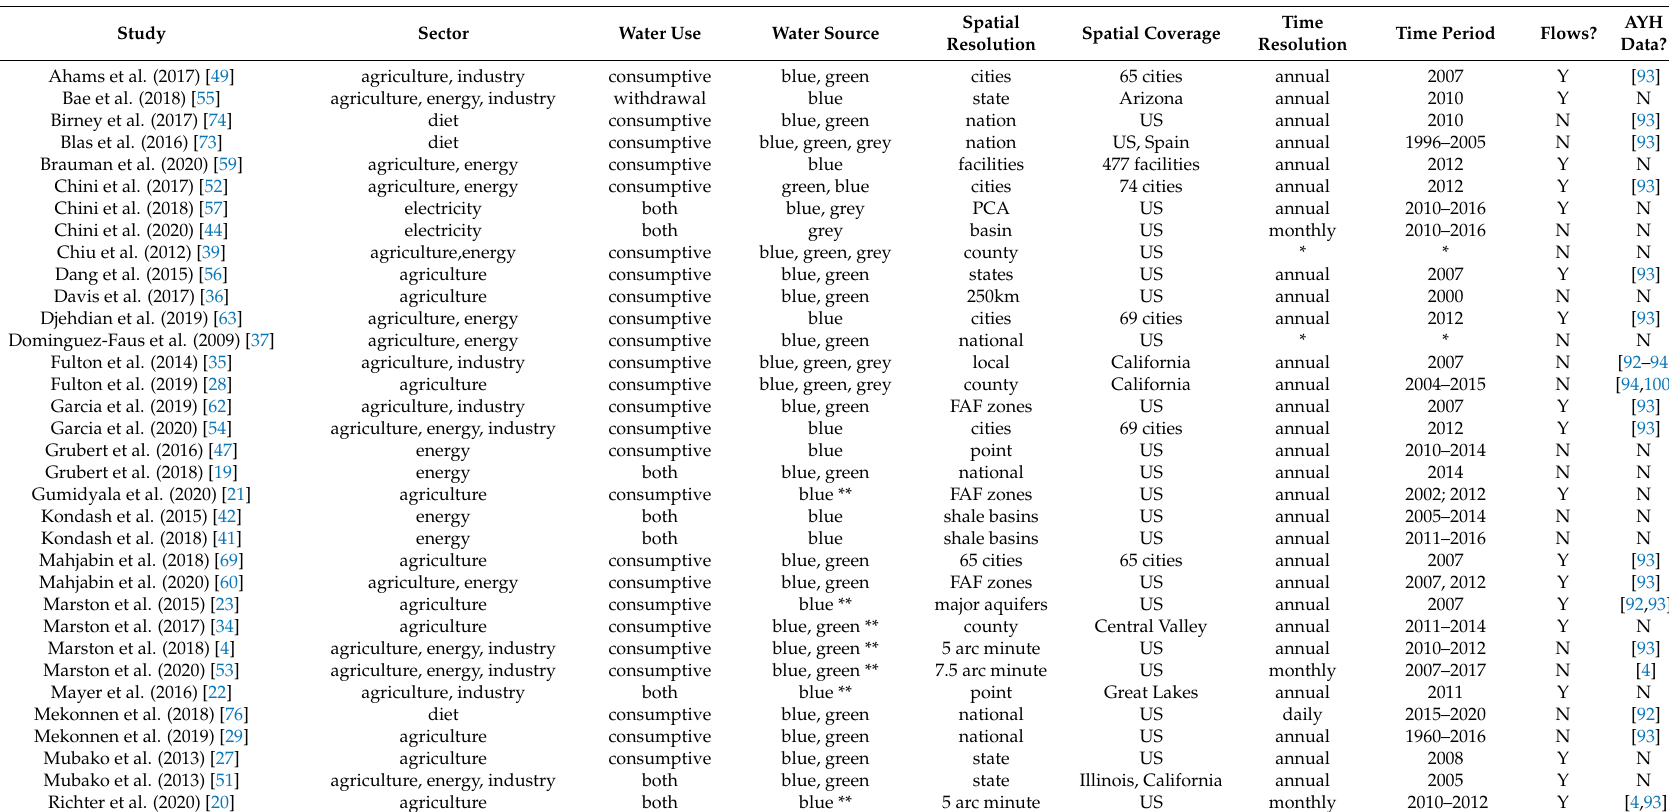
Table 1. Studies of the water footprint of the United States. Details on the economic sector, spatial resolution and coverage, temporal resolution and period, and type of water use are provided. Most studies include multiple spatial and temporal datasets so the predominant scale is denoted here. Studies that integrate Arjen Y. Hoekstra’s data are